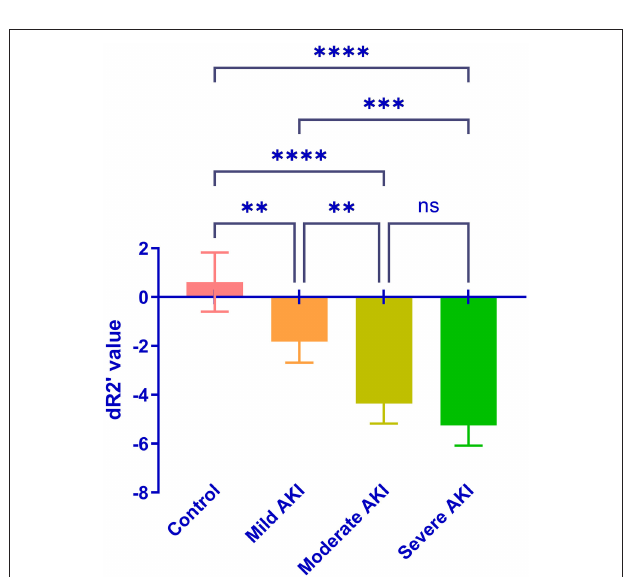
FIGURE 6 | Comparison of the dR2’ in the control and AKI groups. Significant differences were found by one-way ANOVA among groups ( P < 0.0001). ** P < 0.01; *** P < 0.001; **** P < 0.0001; ns, not